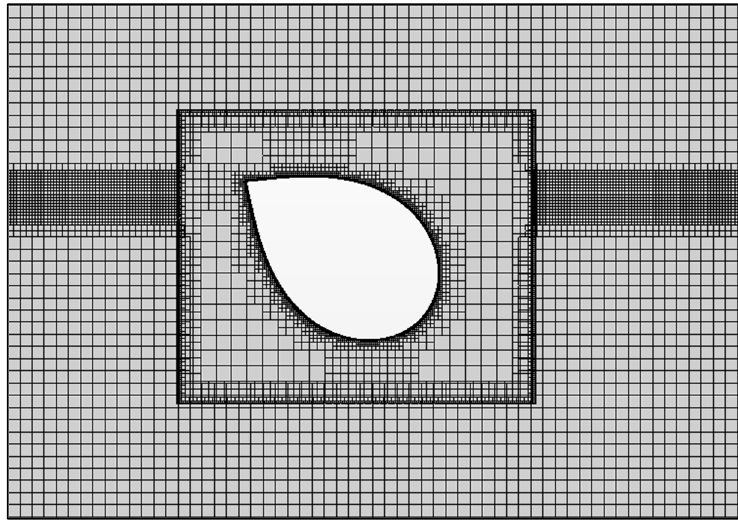
Figure 7. WEC rotor geometry with mesh in and around at the rest position.